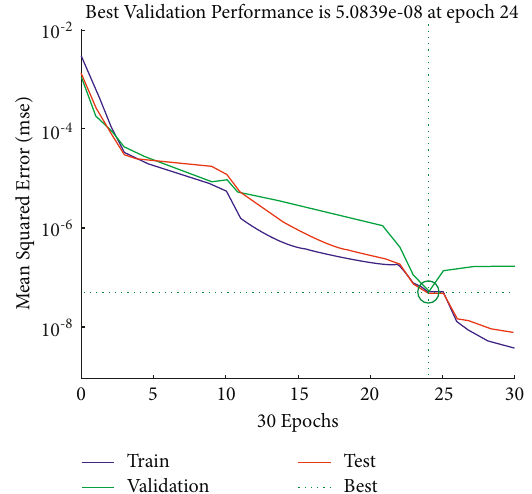
Figure 5: PSO-BP algorithm-based the best performance